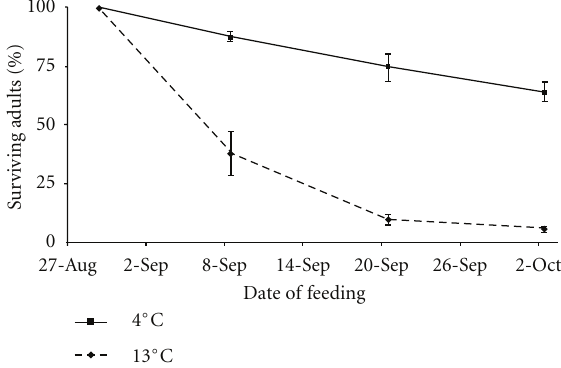
Figure 2: Mean percentage ( ± S.E.) of the original adults surviving at each feeding period maintained at 13 ◦ and 4 ◦ C in the weeks following emergence in